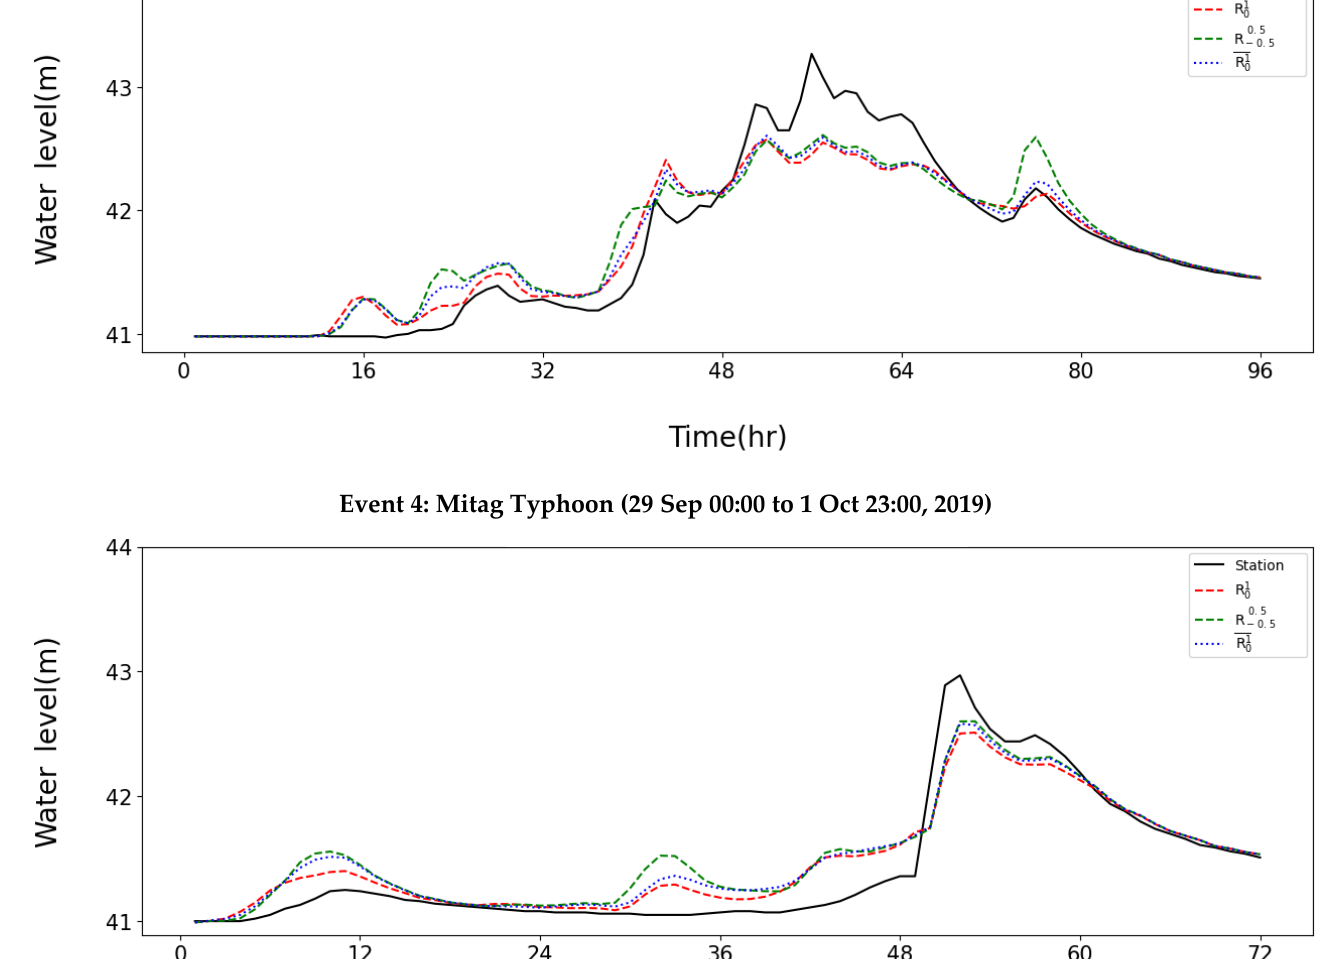
, R 0.5 − , R 1 0 0.5 0